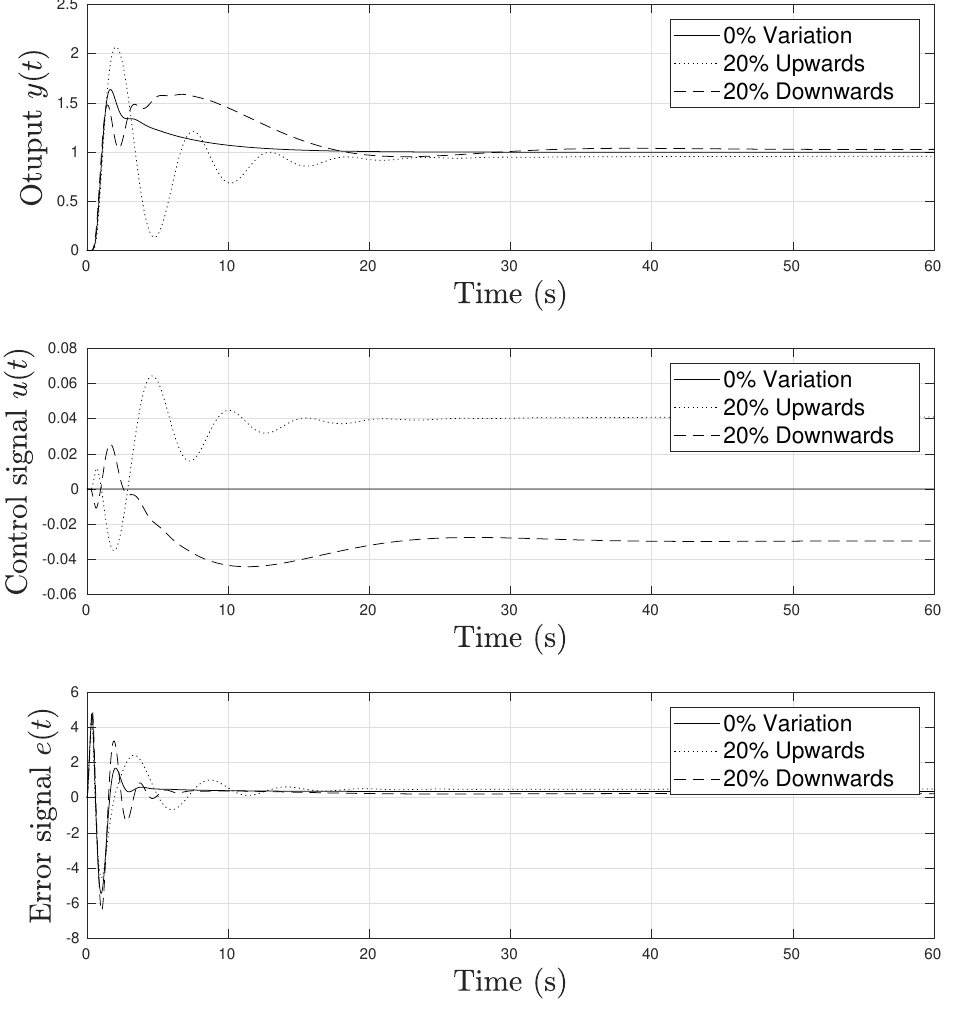
Figure 8. Response for two unstable poles with parameters